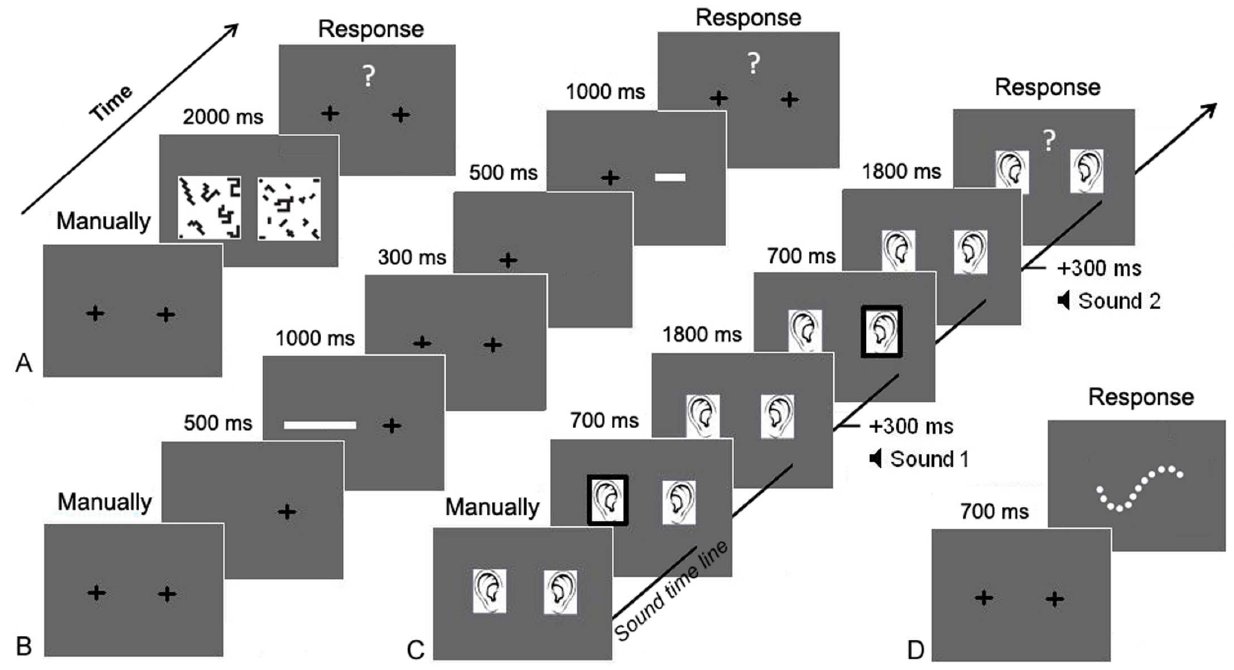
Figure 1. Timing of events during a trial. From left to right, each panel shows the succession of events during a trial in the numerosity (A), the length (B), the duration (C) comparison tasks and the speeded counting task (D).